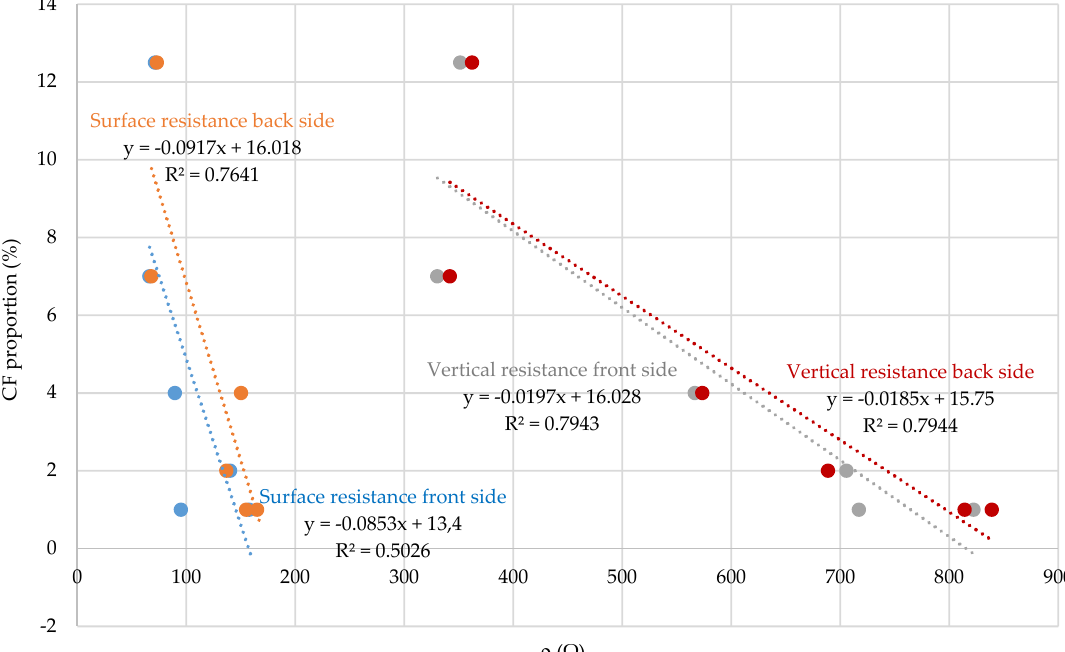
Figure 10. Correlation coefficient, equation and regression line of electrostatic resistance and CF proportion in the woven fabric.